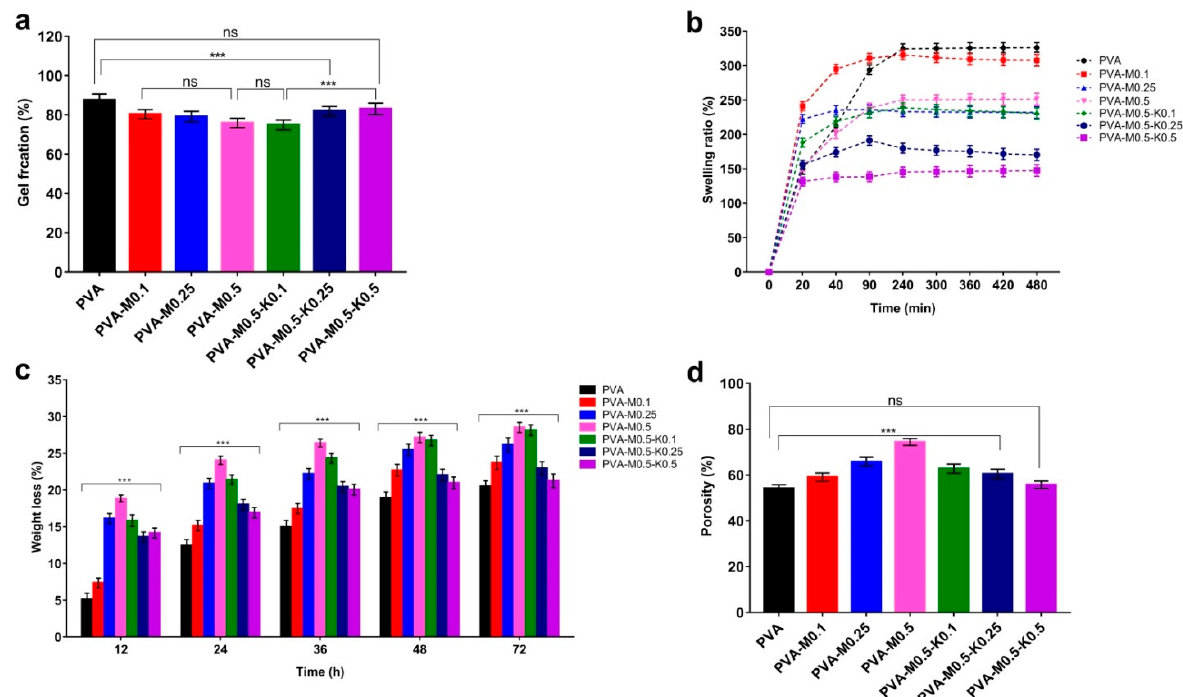
Figure 6. ( a ) Gel fractions, ( b ) Swelling characteristics, ( c ) In vitro weight loss, and ( d ) Porosity evaluations PVA/marjoram, and PVA/marjoram/kaolin composite sponges compared with the pure PVA sponge. Results are stated as means ± SD ( n = 5) (*** p < 0.001, and (ns) points to non-significant difference).